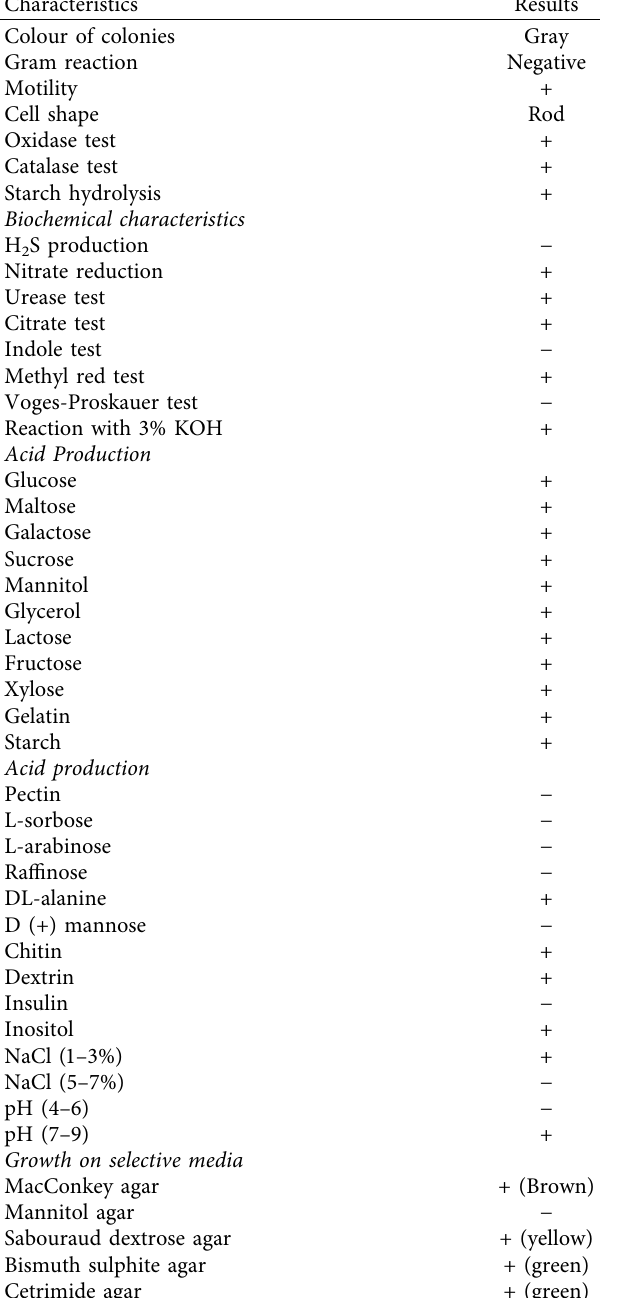
Table 3: Morphological and biochemical properties of isolate DO5.